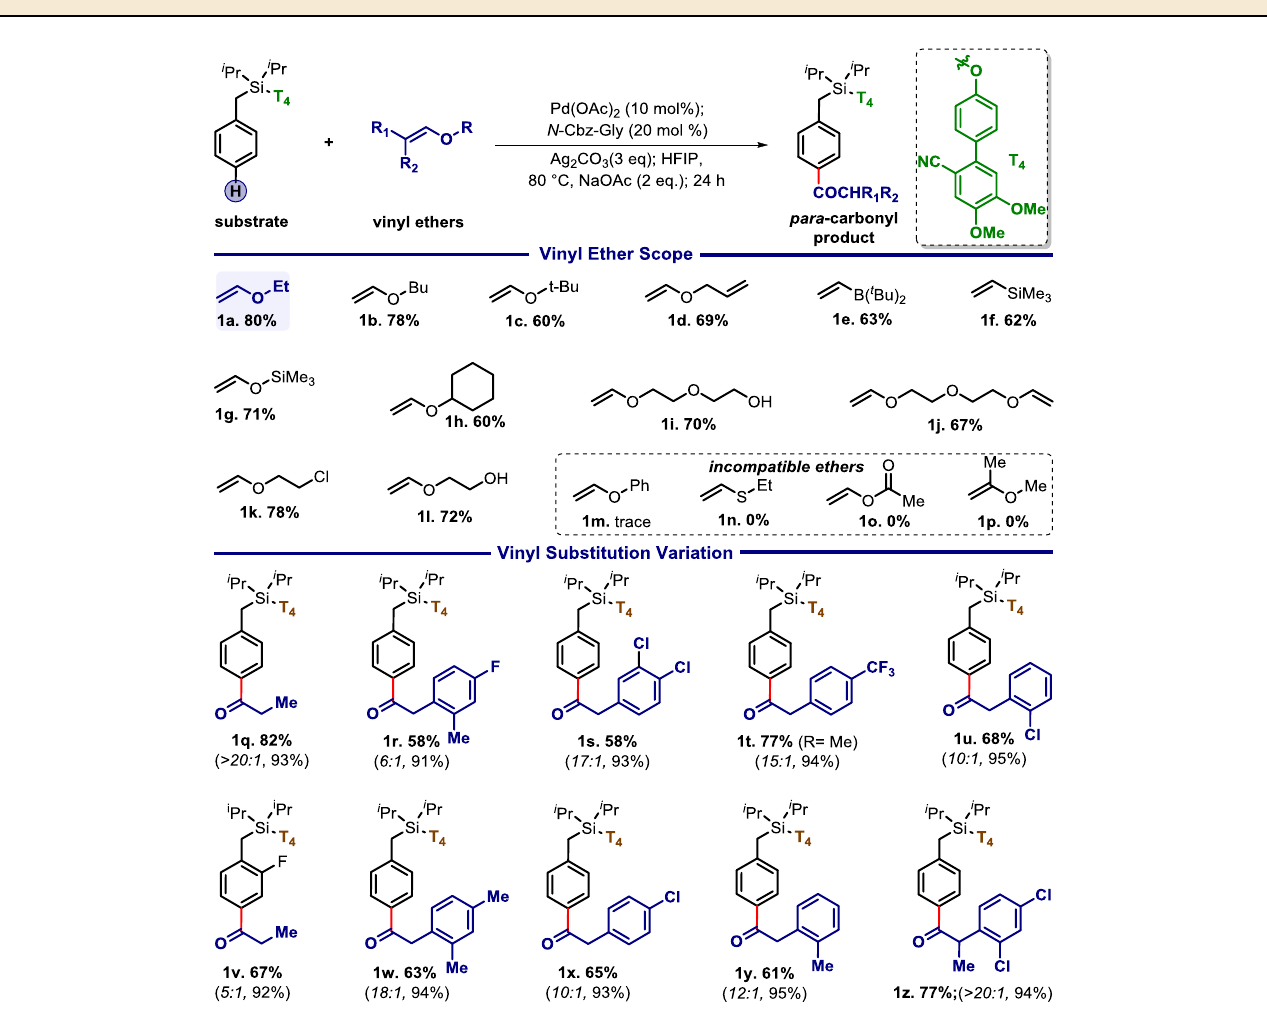
(Table 3: 3a – 3k ). Poly-halo compounds, specially poly- fl uoro, which is having signi fi cant medicinal values can be